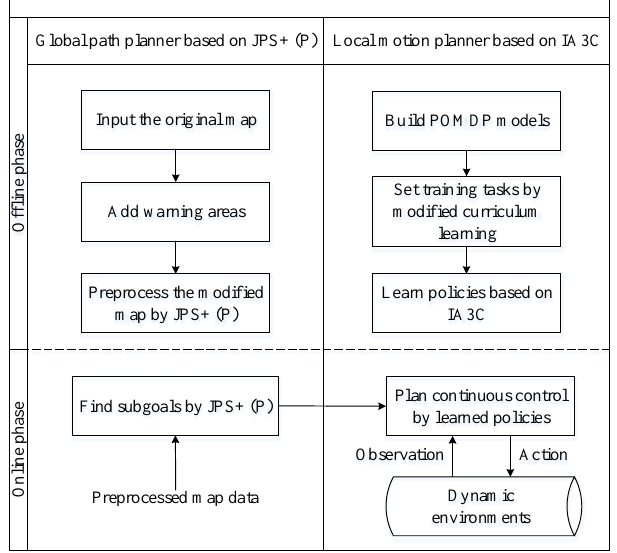
Figure 2. Flowchart of the Jump Point Search improved Asynchronous Advantage Actor-Critic (JPS-IA3C) method.